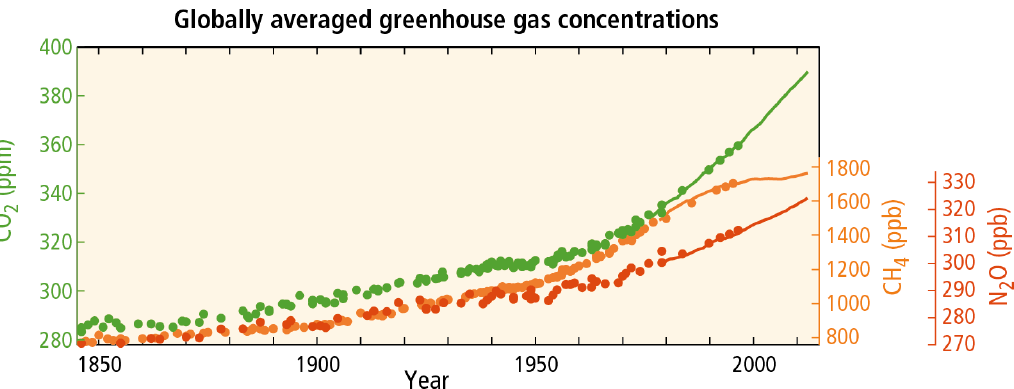
Figure 1. GHG levels since 1850. The green line represents the increase in CO 2 concentration since 1850; the orange line represents the increase in CH 4 concentration since 1850; lastly, the red line represents the increase in N 2 O since 1850 [19].